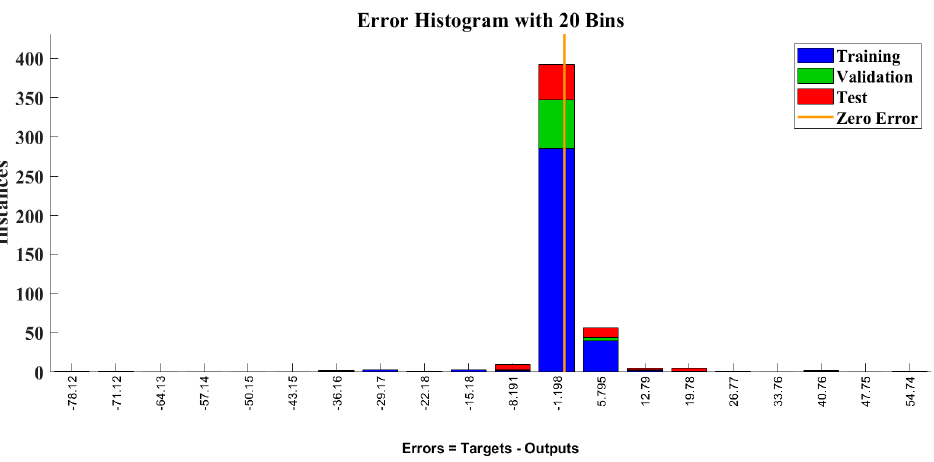
Figure 11. Error histogram plot of the LPG plant training, validation, and testing datasets.